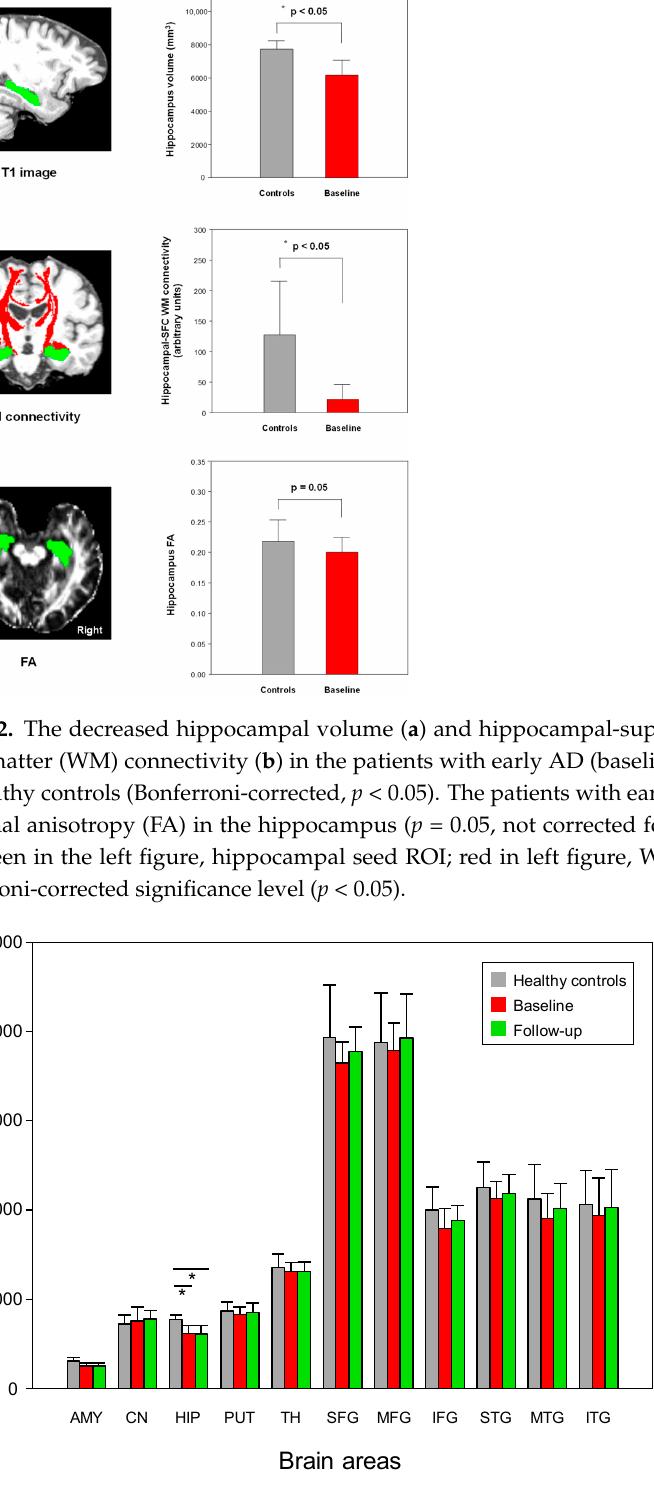
Figure 3. The mean brain volume in the 11 ROIs in the patients with early AD (baseline and 6-month follow-up) and the healthy controls. However, no significant differences were detected in the 11 ROIs before and after donepezil treatment in the patients with early AD. AMY; amygdala, CN; caudate nucleus, HIP; hippocampus, PUT; putamen, SFG; superior frontal gyrus, MFG; middle frontal gyrus, IFG; inferior frontal gyrus, STG; superior temporal gyrus, MTG; middle temporal gyrus, ITG; inferior temporal gyrus. * Meets Bonferroni-corrected significance level ( p < 0.05). Compared with the healthy controls, the patients with early AD had a higher MD and RD in the amygdala ( p < 0.05, Bonferroni-corrected) (Figure 4, Supplementary Tables S3 and S4). The patients with early AD had a lower FA in the hippocampus and amygdala ( p ≤ 0.05, not corrected for multiple comparisons) (Figure 2, Supplementary Table S2). None of the other ROIs showed significant differences in MD and RD between the healthy controls and the patients with early AD (Supplementary Tables S3 and S4). In addition, no significant difference ( p > 0.05) was detected in the DTI scalars of the 11 ROIs before and after treatment in the group of patients with early AD (Supplementary Tables S2–S5).